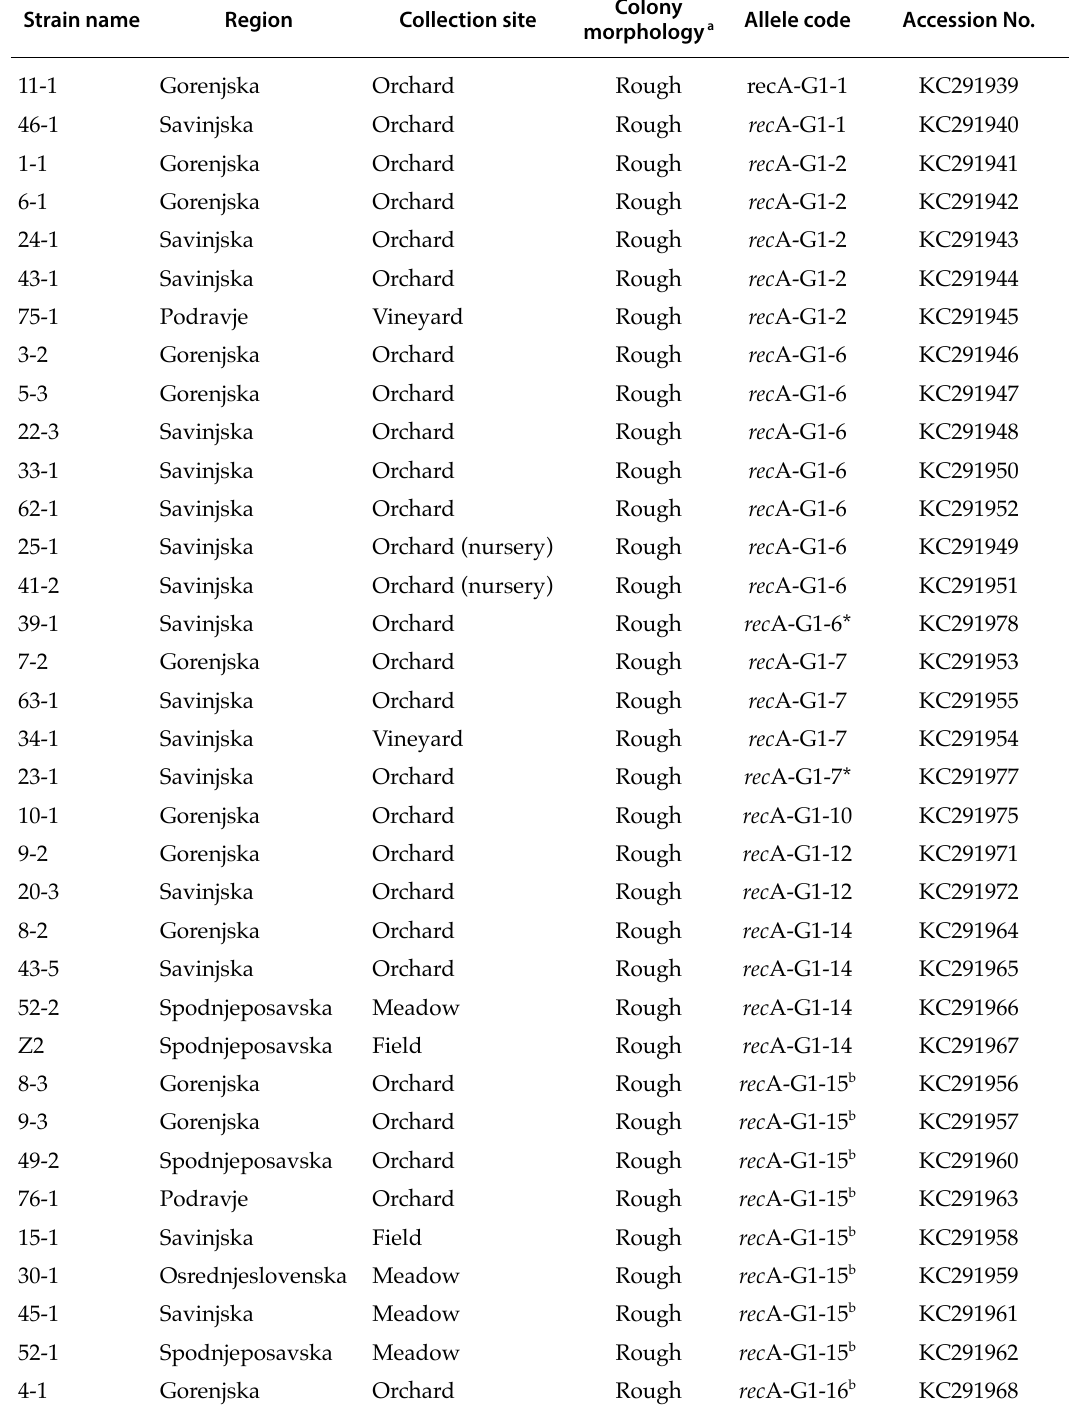
Table 1. Origin, observed colony morphology, and determined rec A alleles with sequence accession numbers of strains of Agrobacterium tumefaciens biovar 1 soil populations from agricultural lands in